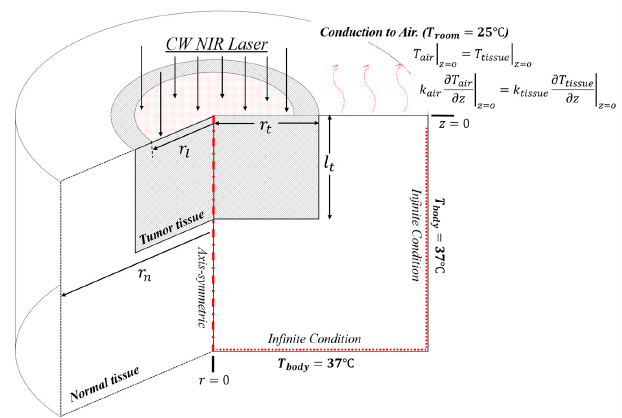
Figure 4. A schematic of the geometry and boundary conditions for numerical analysis.